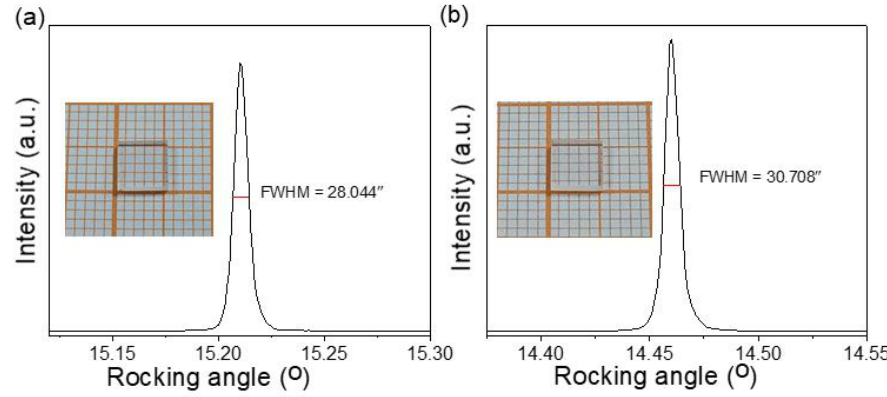
Figure 6. ( a , b ) the rocking curves of KBOB-L and KBOB-LF, respectively.